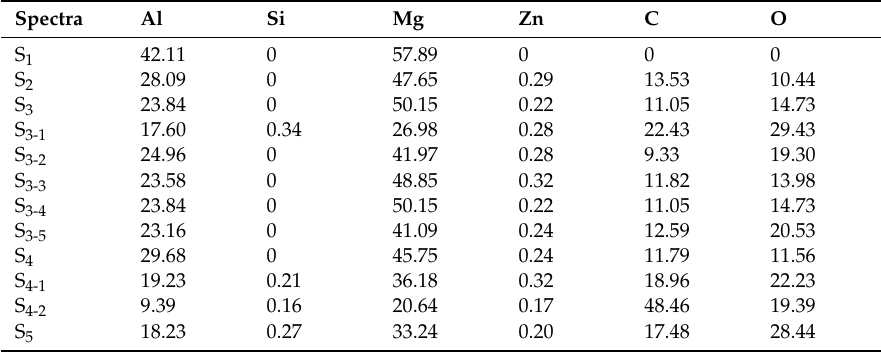
Table 2. Chemical composition (at.%) of the microstructures observed in the weld pool.